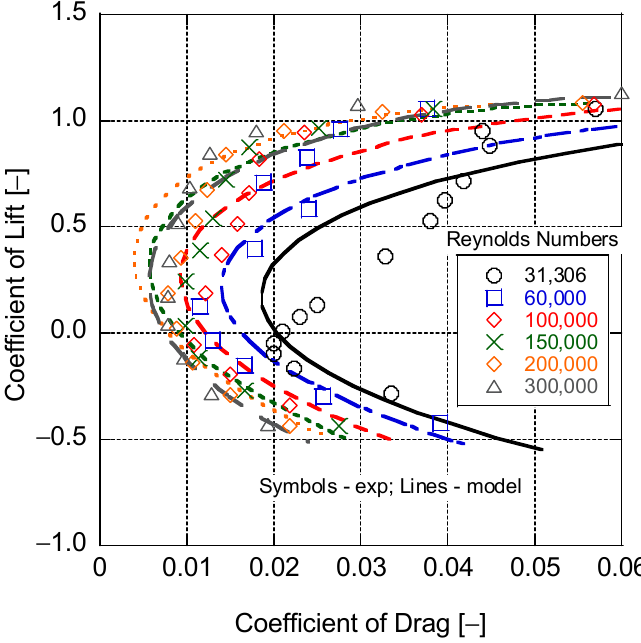
Figure 5. S7012 Airfoil C l and C d data and model predictions over varying Reynolds numbers.